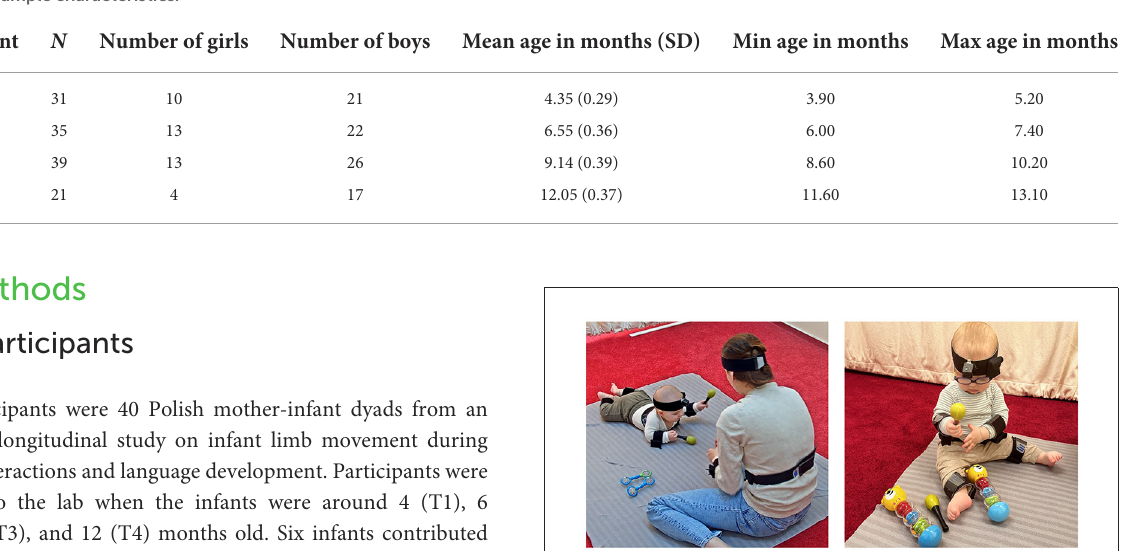
TABLE 1 Sample characteristics.